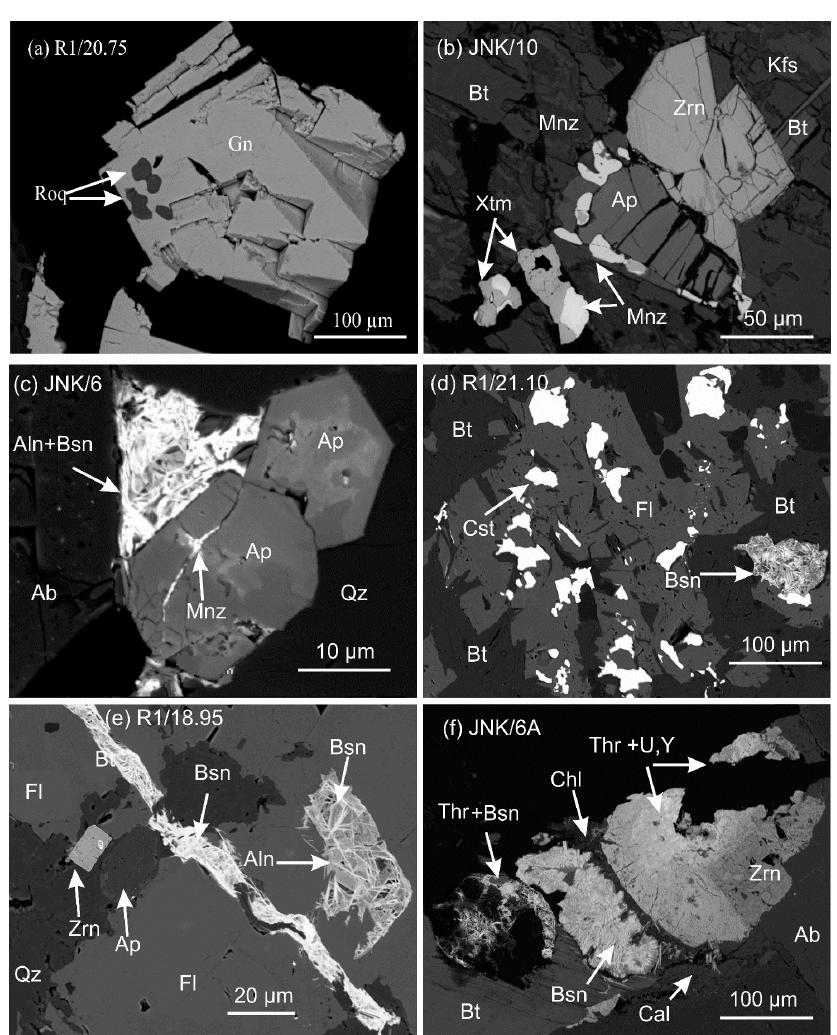
Figure 15. Back-scattered electron images REE-bearing minerals in Kymi granite stocks; ( a ) Cubic galena (Gn) crystals contain roquesite (Roq); ( b ) Coarse zircon (Zrn) crystals associated with apatite (Ap), monazite (Mnz) and xenotime (Xtm); ( c ) Hexagonal prismatic apatite (Ap), allanite (Aln) and bastnäsite (Bsn) intergrown in the outer rim of the apatite; ( d ) Bright inclusions of cassiterite (Cst) within fluorite (Fl); ( e ) Acicular/needle-like bastnäsite (Bsn) filling fractures within fluorite (Fl) and quartz (Qz); ( f ) Altered zircon associated with Y-Th-U minerals and bastnäsite (Bsn).